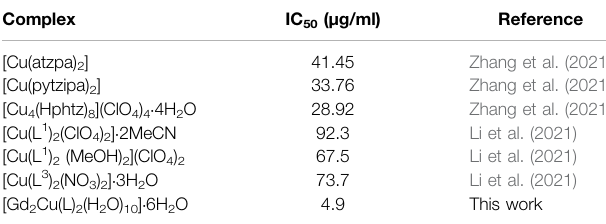
TABLE 2 | Comparison of cytotoxicity with other Cu(II) complexes for HeLa cells. Complex IC 50 ( μ